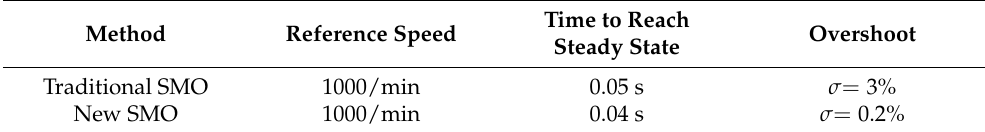
Table 3. The comparative simulation results of startup.